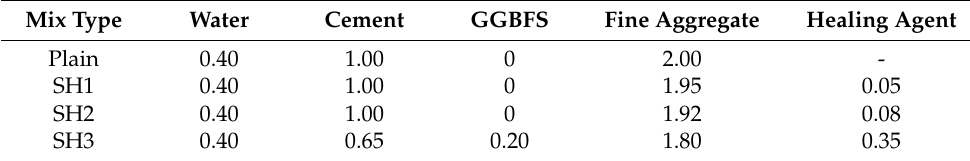
Table 1. Mix proportions for the Plain and three self-healing mortar